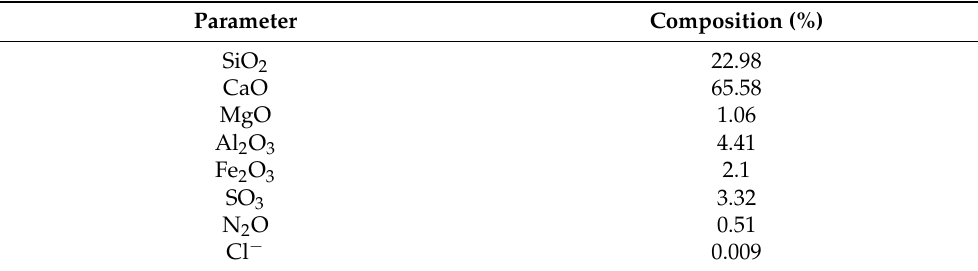
Figure 1. The main materials used in the study. ( a ) Portland cement ( b ) fine sand ( c ) aggregates ( d ) metal formworks. Table 1. Physicochemical properties of the Portland cement used in the study.